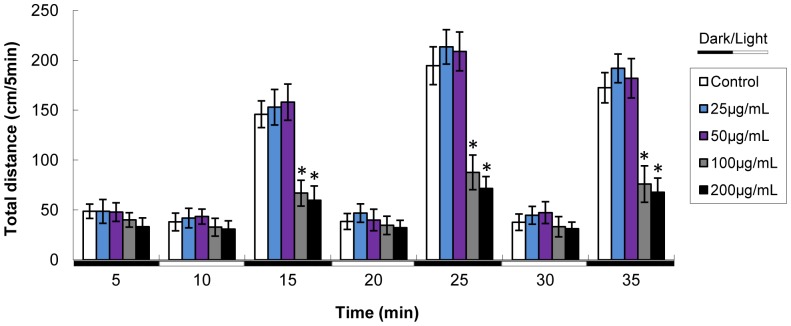
Locomotor activity of zebrafish larvae using the tracking sets during alternating periods of light and dark.White and black bars at the bottom denote light and dark periods, respectively. Data are expressed as means ± S.D. from three independent experiments, n = 24 (*p<0.05).